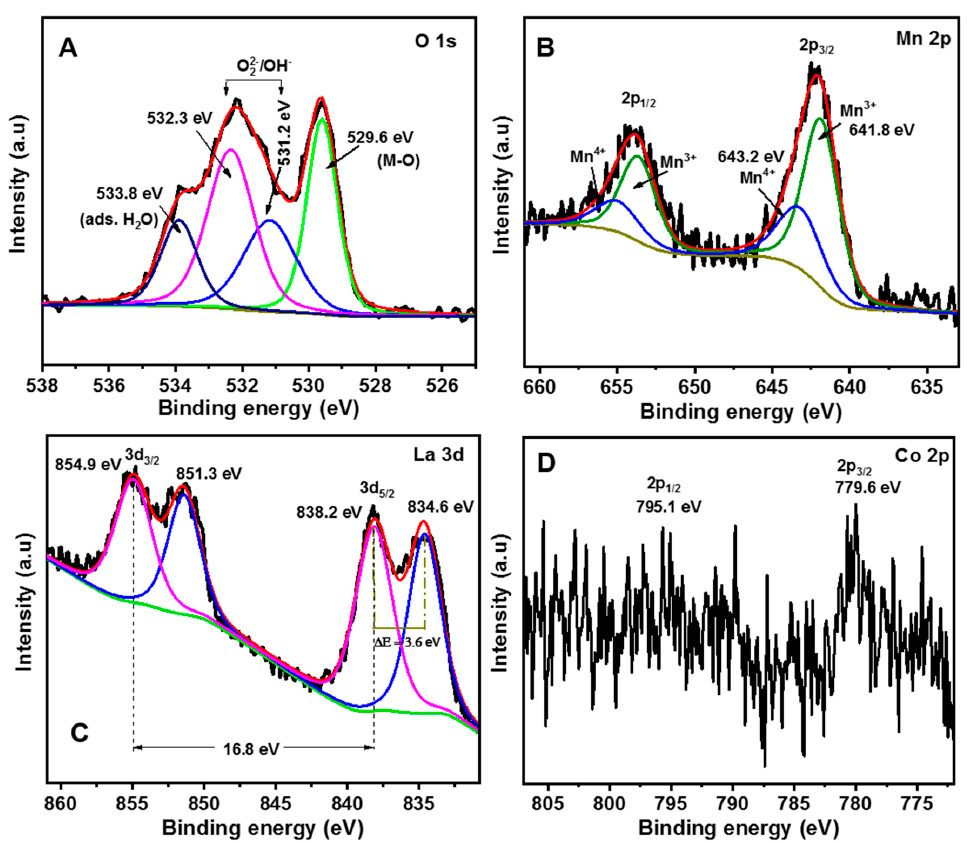
Figure 3. XPS curve of high-resolution spectra of O 1s ( A ), Mn 2p ( B ) , La 3d ( C ) , and Co 2p, ( D ) in LaMnO 3 @C-Co 3 O 4 composite.